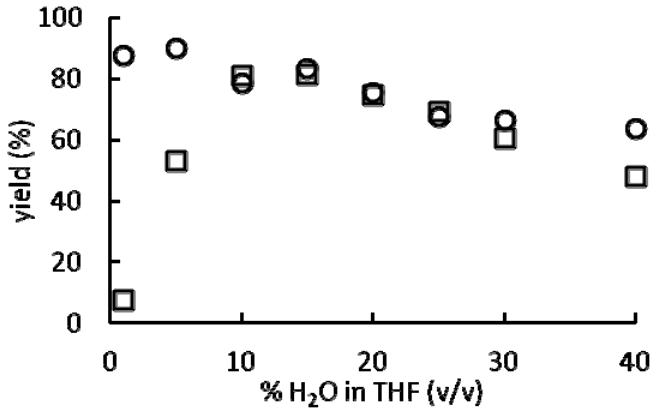
Figure 3. Yields of the reaction shown in Figure 1 catalyzed by Eu(OTf) after 48 h as a function of solvent composition. Conditions: solvent mixtures of 1 to 40%